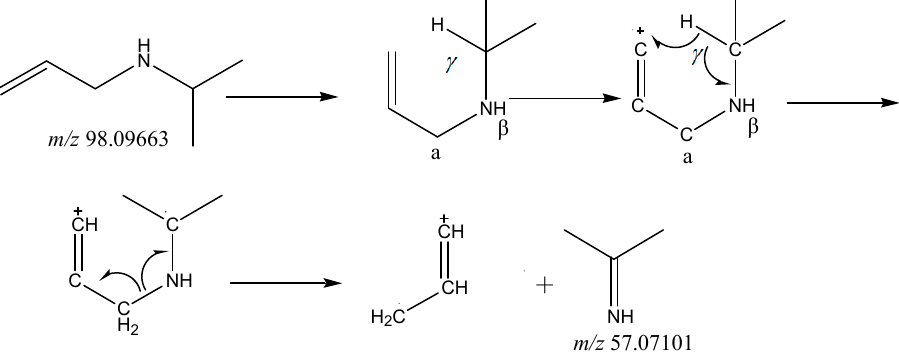
Figure 5. The McLafferty Rearrangement of m /z 98.09663.